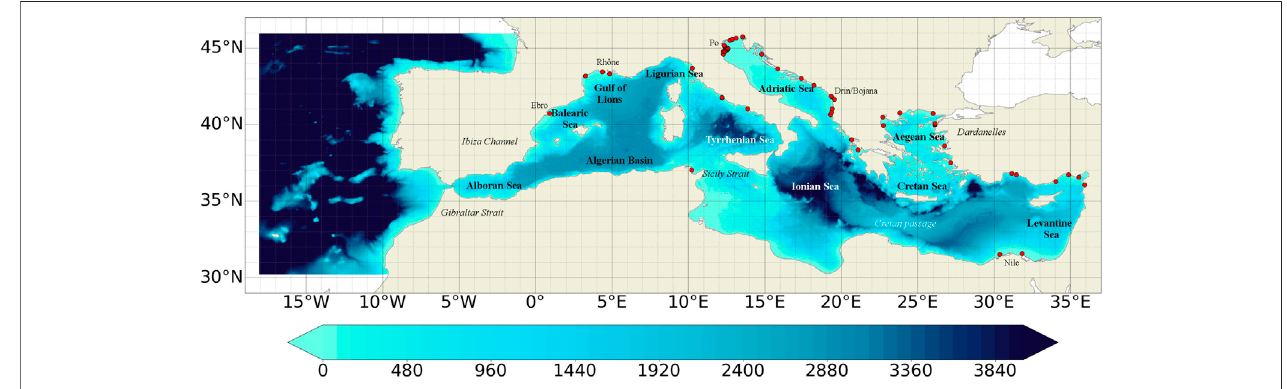
FIGURE 1 | Domain and bathymetry of MEDREA24 (in meters). Position of the river input are in red.